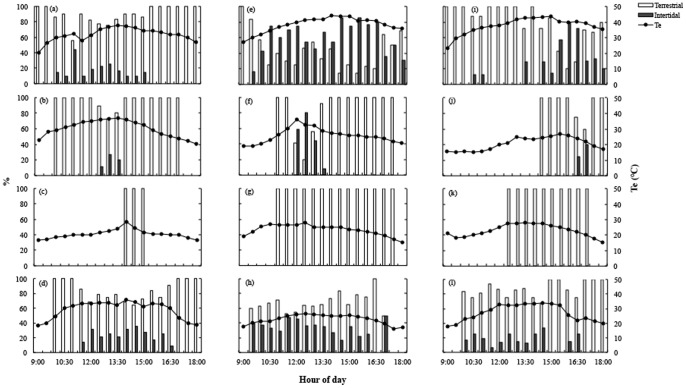
Diel variation of the percentage of active lizards in terrestrial and intertidal habitats in summer, fall, winter, and spring seasons for: Medano (a–d), Zenteno (e–h), and Arrayán (i–l) populations.White bars represent the proportion of individuals in the terrestrial or supralittoral zone; the black ones represent the proportion in the intertidal zone. Maximal abundance in the day was considered as 100%. Circles represent Te (measured with Tidbits data loggers) in the intertidal and terrestrial habitats.